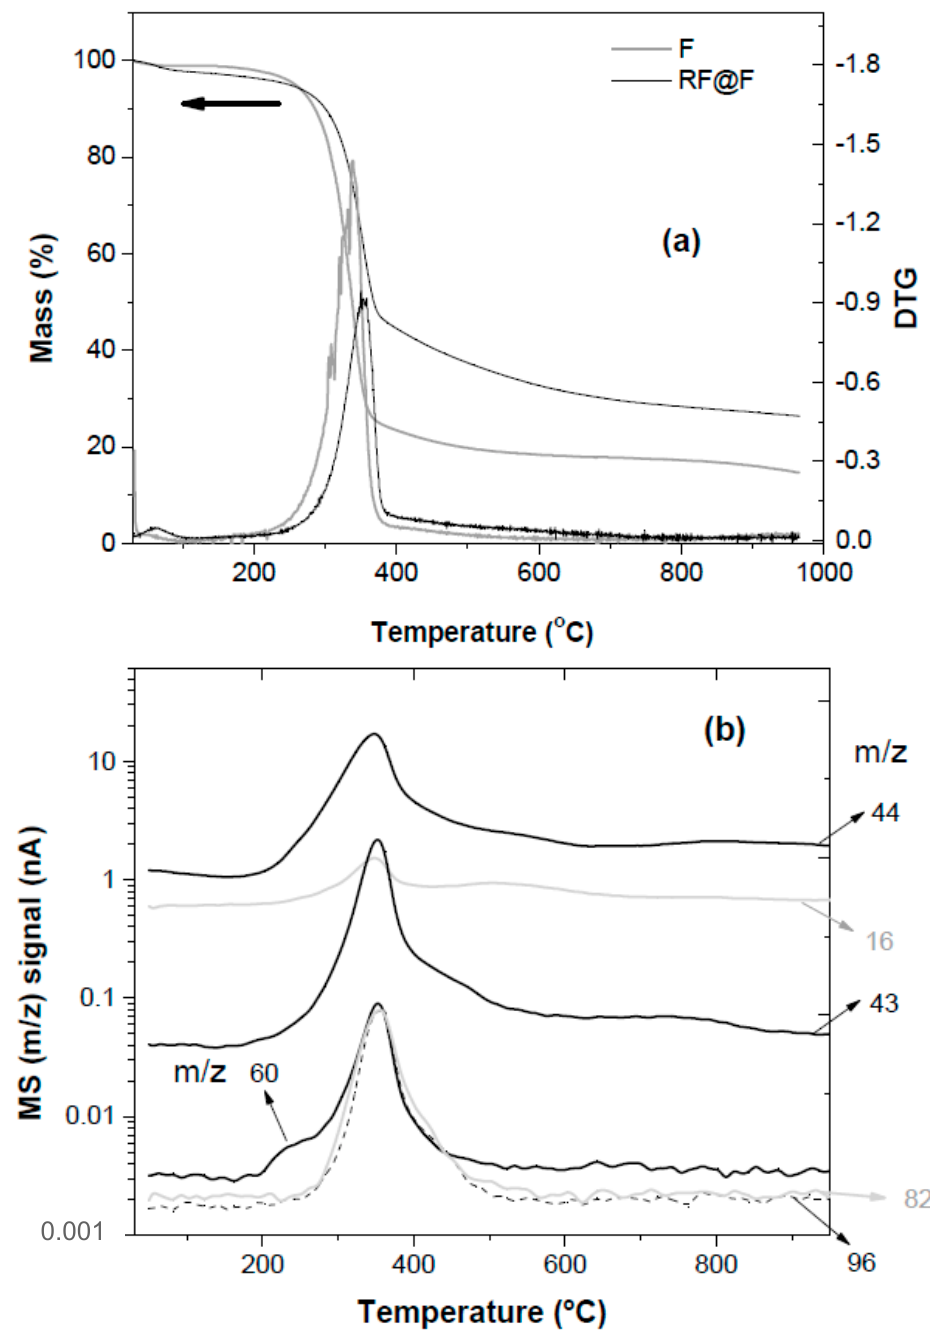
Figure 5. ( a ) Thermogravimetric (TGA and DTG) plots of cellulose fabric alone (F, grey line) and composite resin (RF@F, black line) during carbonization. ( b ) MS plots (from TGA/MS) of selected fragments produced during composite carbonization.